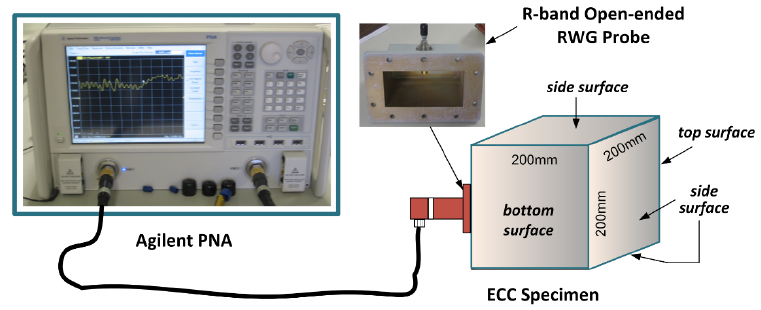
Figure 2. Schematic of microwave measurement